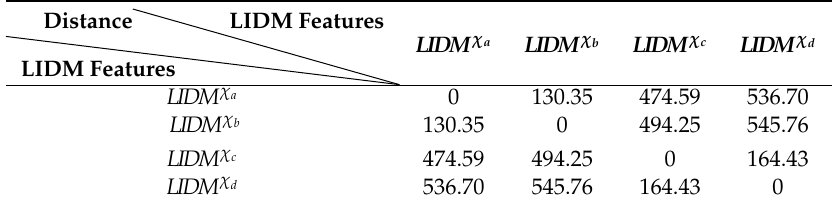
Table 1. Exhibition of Hausdorff distances between different LIDM feature